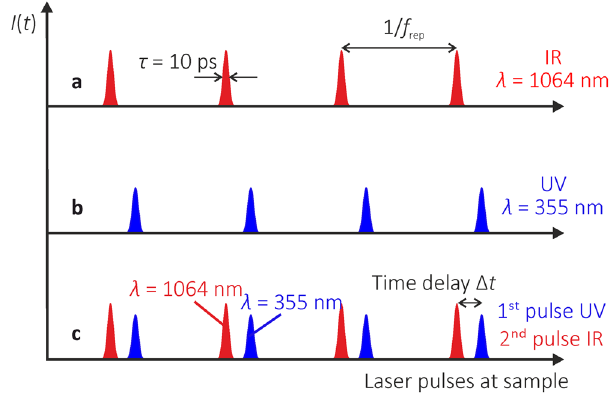
Figure 7. Principal scheme of the irradiation regimes. Schematic representation of the laser intensity versus arrival time of laser pulses at the sample: ( a ) single-pulse IR irradiation at the wavelength of 1064 nm; ( b ) single- pulse UV irradiation at the wavelength of 355 nm; ( c ) dual-wavelength double-pulse combined irradiation with the variable inter-pulse